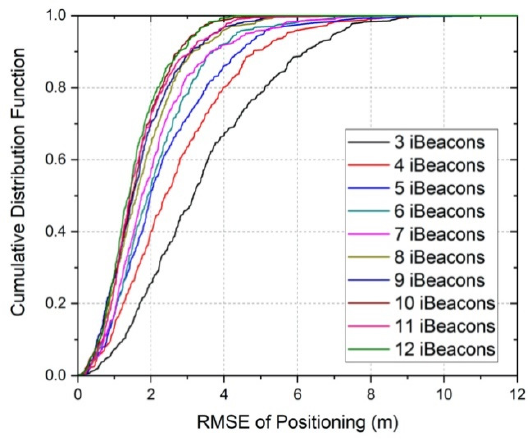
Figure 9 . CDF comparison of deploying different number of iBeacons.